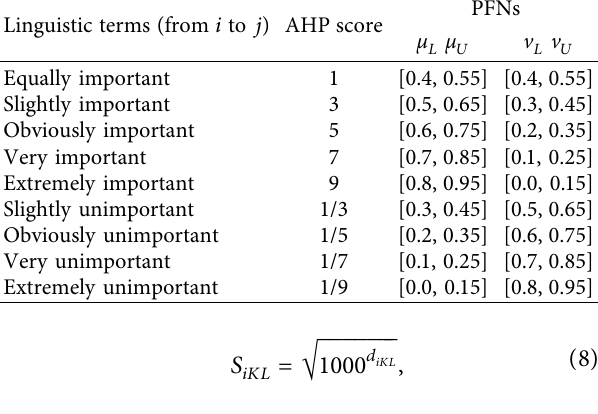
Table 3: Evaluation scores for weight vectors in AHP and PFNs. Linguistic terms (from i to j ) AHP